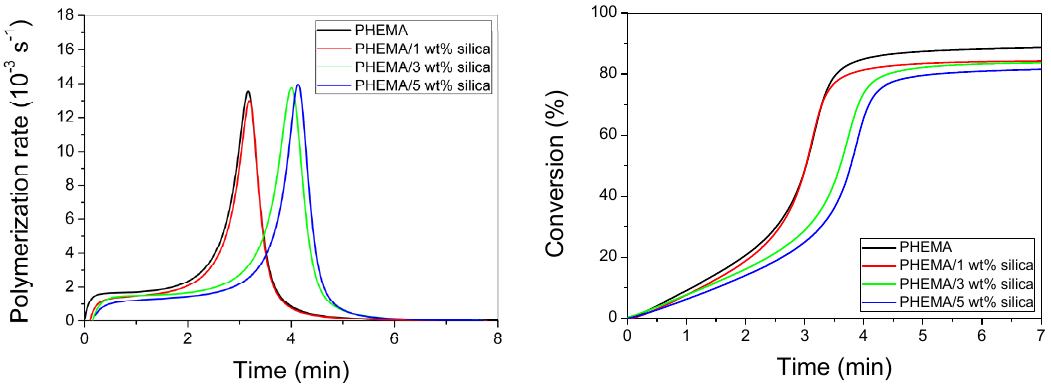
Figure 8. Relative effective kinetic rate constants obtained during polymerization of